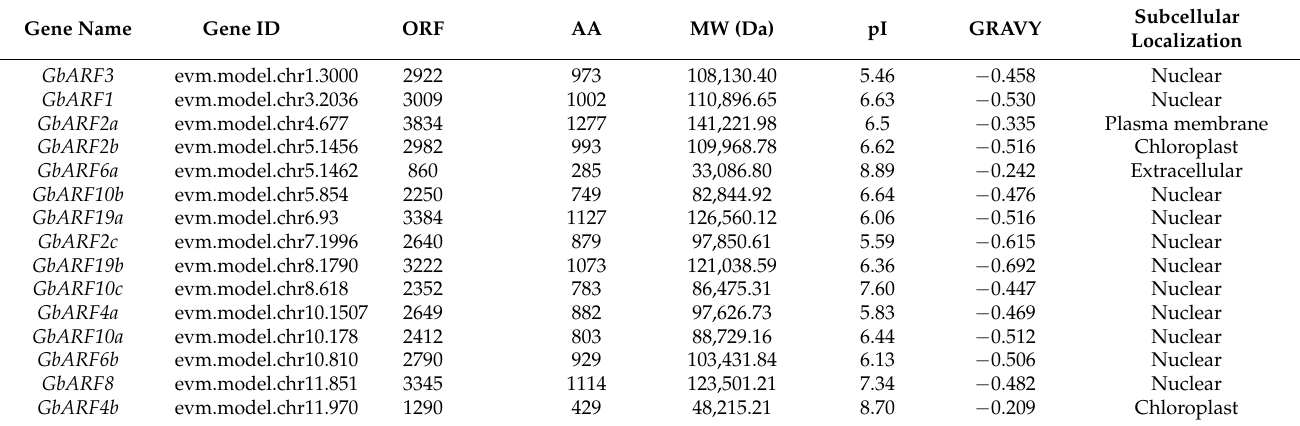
Table 1. The protein characteristics of GbARFs in Ginkgo.